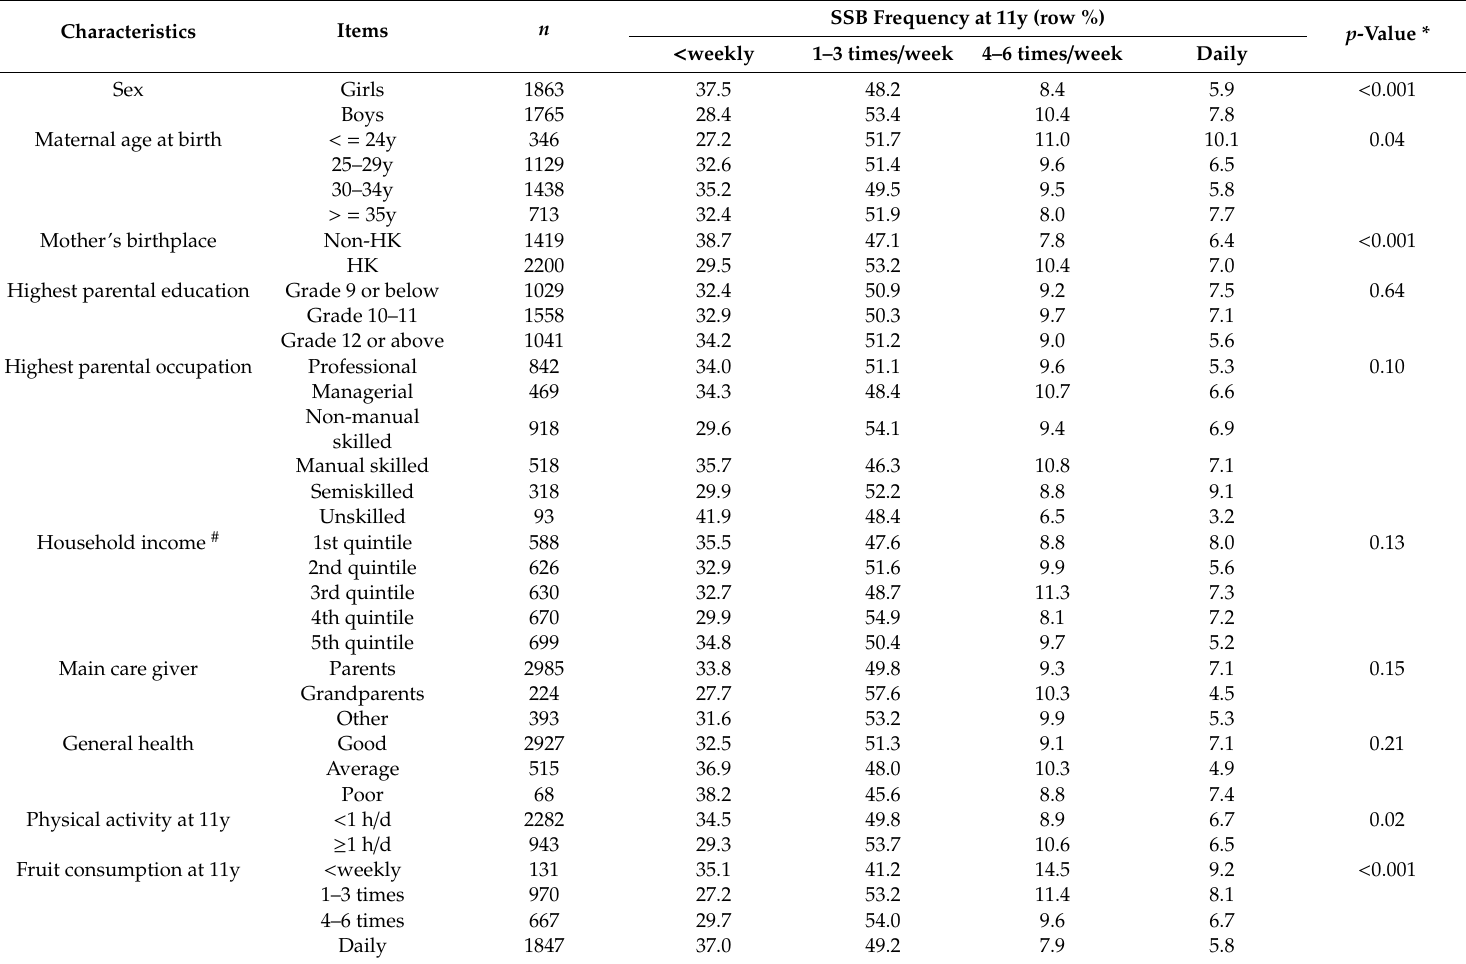
Table 1. Characteristics by sugar-sweetened beverage (SSB) consumption at 11 years for 3628 children in Hong Kong’s “Children of 1997” birth cohort.